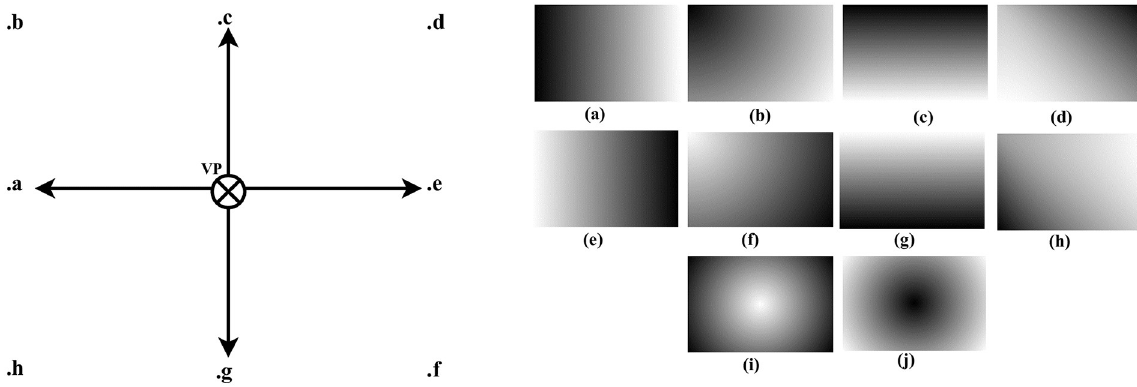
Fig 8. Image profiles/hypothesis generation base on vp (.a, .b, .c, .d, .e, .f, .g, .h, .i,